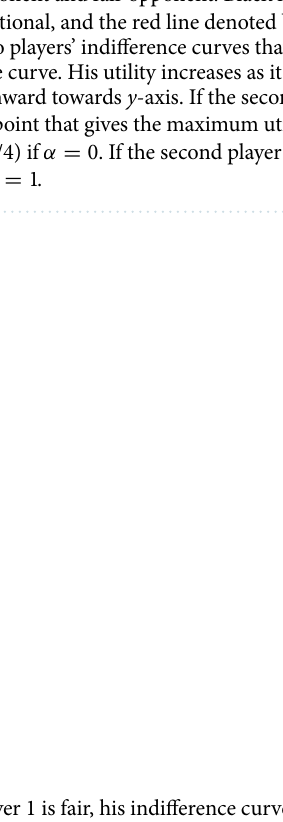
Figure 5. Equilibrium bids when both players are fair If player 1 is fair, his indifference curve has the zero slope on x F ( y ) , not on x R ( y ) , because x F ( y ) is the optimal point for him given y . This figure shows the equilibrium bids (9/29, 19/58), which is the tangent point of player 1’s indifference curve and player 2’s reaction curve y F ( x ) , when both are fair, if α = 1